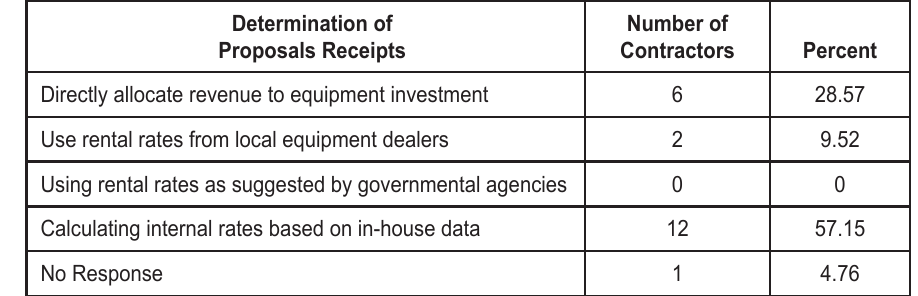
Table 5: Determination of proposals receipts